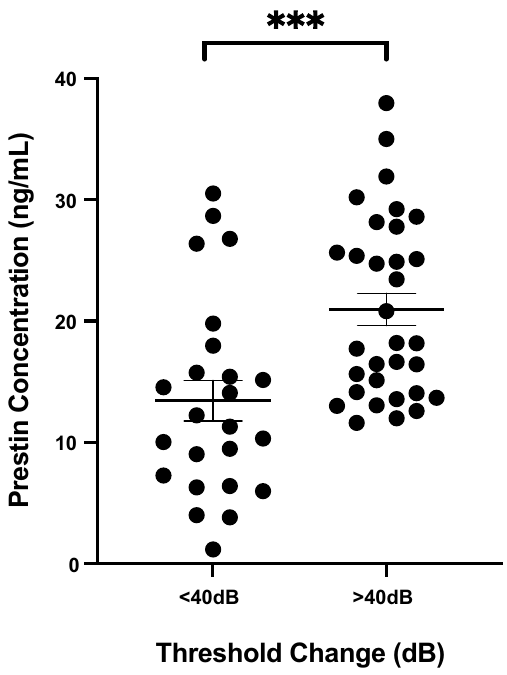
Figure 4. Serum prestin concentration (ng/mL) in mice with summative ABR threshold shifts of > 40 dB at 24 kHz and 32 kHz frequencies. Error bars represent standard error of mean (SEM), *** <